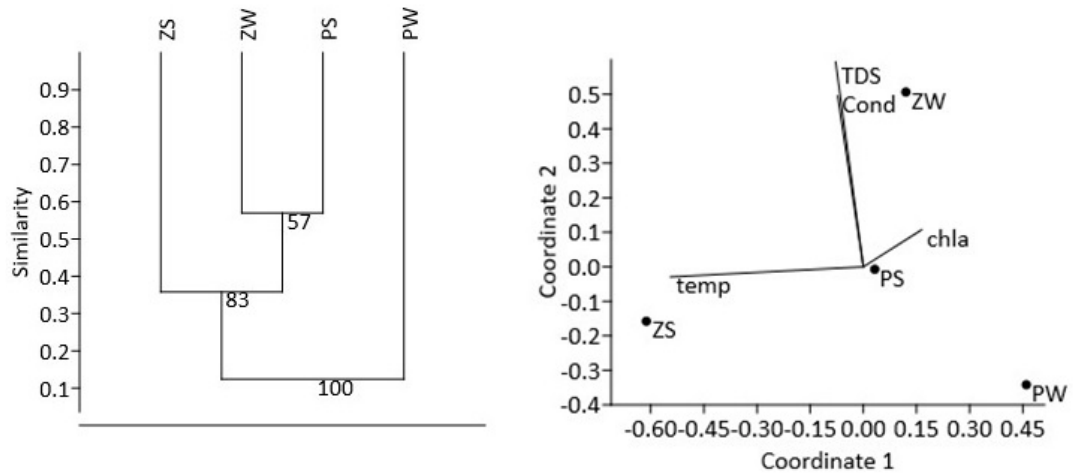
Figure 4. Cluster analysis based on Morisita similarities at the OTU level ( left ) and NMDS analysis based on Bray-Curtis index with fitted environmental variables ( right ) for Pamvotis (P) and Ziros (Z) samples in winter (W) and summer (S). Values at the nodes of the cluster correspond to bootstrap values. The correlation coefficients between each environmental variable and the NMDS scores are presented as vectors from the origin. The length of the vectors is arbitrarily scaled and only their directions and relative lengths should be considered. Temp: temperature, TDS: total dissolved solids, cond: conductivity, chla: chlorophyll-a.